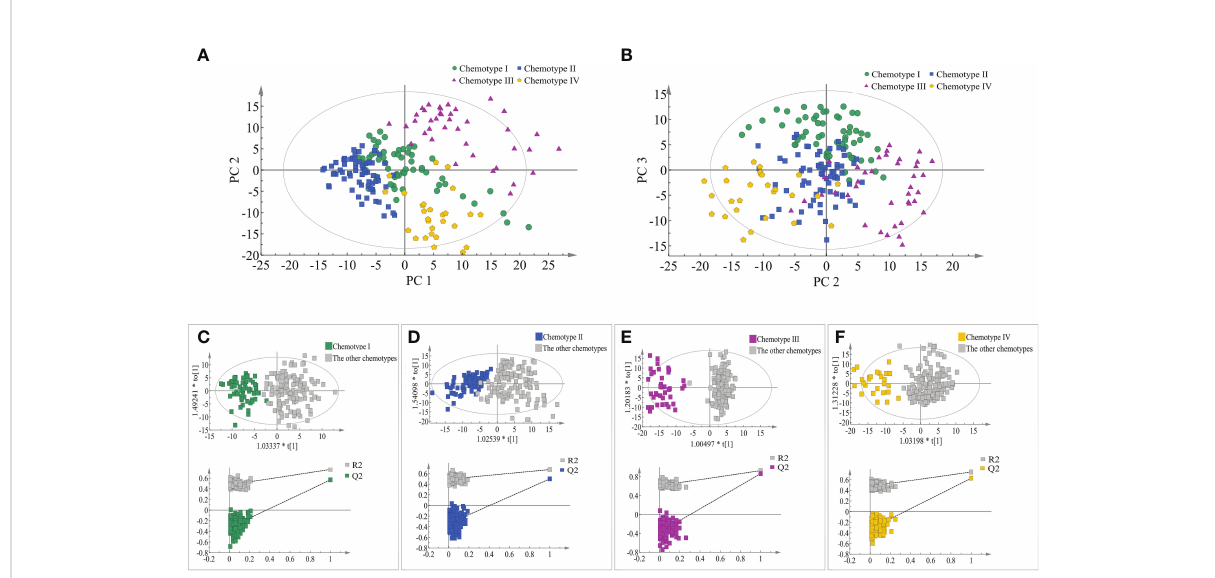
FIGURE 3 Comparisons of the four classi fi ed chemotypes. (A) The four chemotypes compared by PC1 and PC2 of PCA model. (B) The four chemotypes compared by PC2 and PC3 of PCA model. (C) Comparisons between chemotype I and the other chemotypes by OPLS-DA model. (D) Comparisons between chemotype II and the other chemotypes by OPLS-DA model. (E) Comparisons between chemotype III and the other chemotypes by OPLS-DA model. (F) Comparisons between chemotype IV and the other chemotypes by OPLS-DA